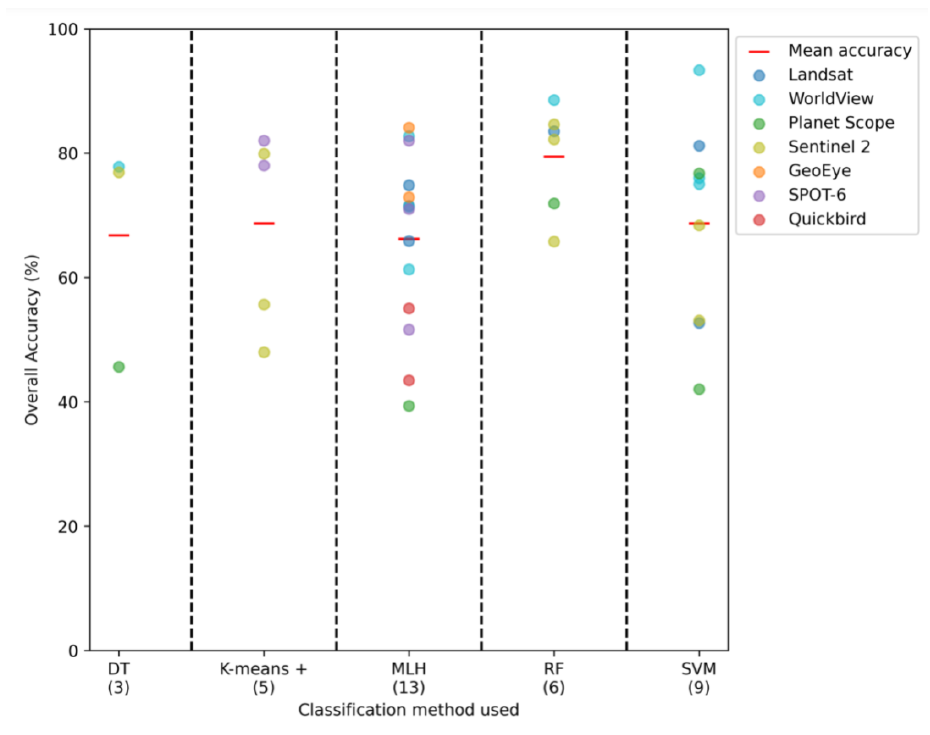
Figure 4. Accuracy of 20 studies from 2018 to 2020 depending on the method and satellite used. One point is a one study, its X-axis value correspond to the method used and its color correspond to the satellite used. One paper can create several points if it used different methods or different satellites. The red line is the mean of each method. The method “K-means +” regroups the methods K-means and ISODATA. “RF” is Random Forest, “SVM” is Support Vector Machine, “MLH” is Maximum Likelihood and “DT” is Decision Tree. The number of studies using each method appears in